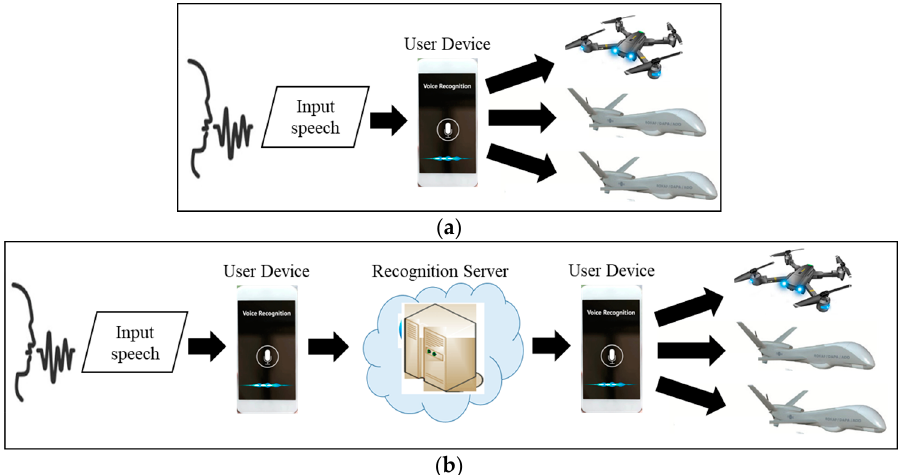
Figure 2. Comparison of ( a ) device-embedded and ( b ) server-centric speech recognition schemes for voice-driven multi-UAV control.